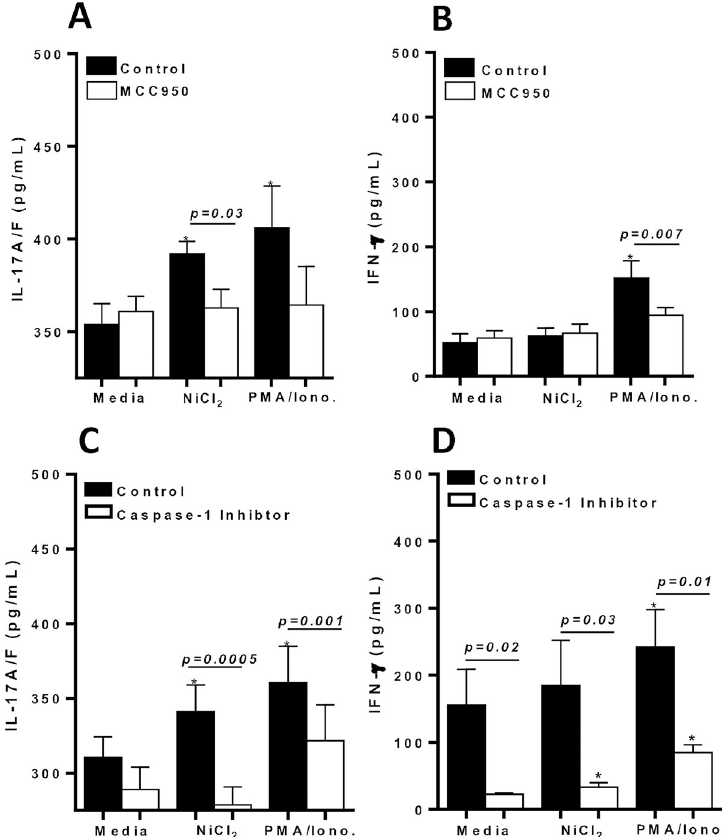
Fig 11. Metal-reactive lymphocytes from individuals’ exhibit significant production of IL-17A/F to metal challenge. Supernatants were harvested on D 6 and assayed by ELISA for production of (A) IL-17A/F or (B) IFN- γ in the absence/presence of metal challenge and/or MCC950 (NLRP3 inhibitor) from n = 3 metal reactive individuals lymphocytes, and (C) IL-17A/F or (D) IFN- γ in the absence/presence of metal challenge and/or Caspase-1 inhibitor from n = 5 metal reactive individuals lymphocytes. Data are shown as mean ± SEM. Asterisk ( � ) signifies statistical significance at p � 0.05 compared to respective control group as determined by paired Student’s t-test.